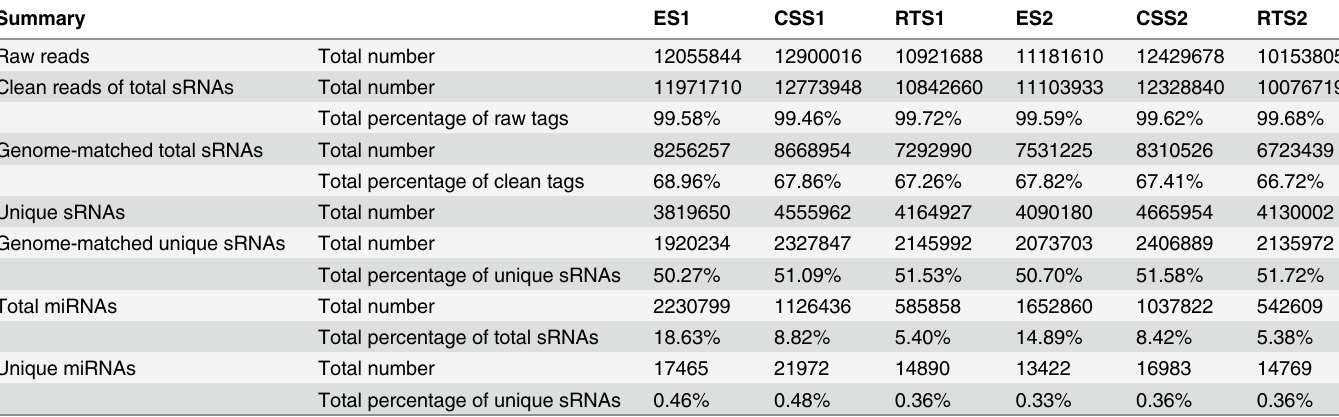
Table 3. Statistics of the sRNA sequences generated from the six